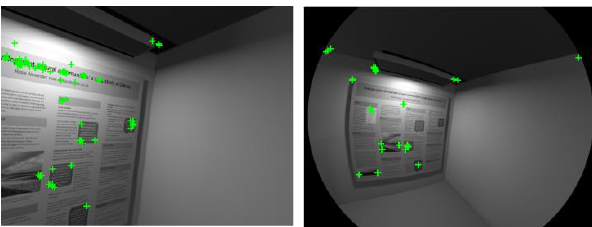
Figure 6. Features after tracking process in perspective view ( left ) and fisheye view ( right ). The green pluses show the features tracked along the image sequence.